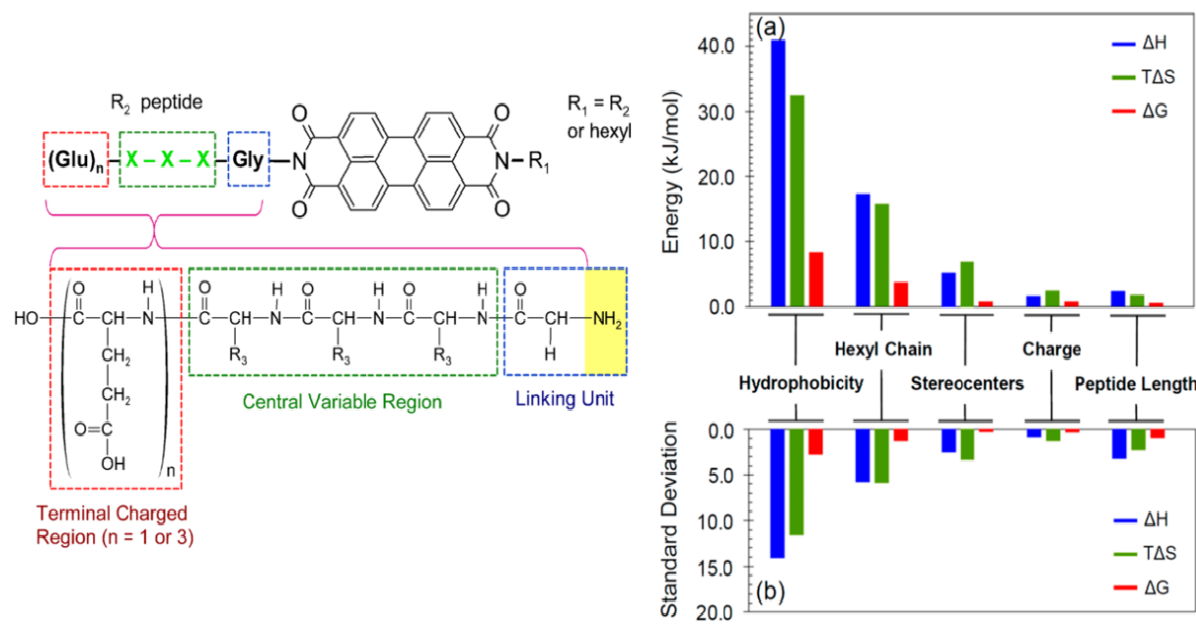
Figure 2. Structure of the peptide – PDI conjugates and impact of structural modulation on the ag- gregation thermodynamics. The histogram shows ( a ) the deviation between the lowest and the high- est values for each parameter, and ( b ) the standard deviation as a more collective measure of varia- bility [39]. Copyright © 2014 American Chemical Society.